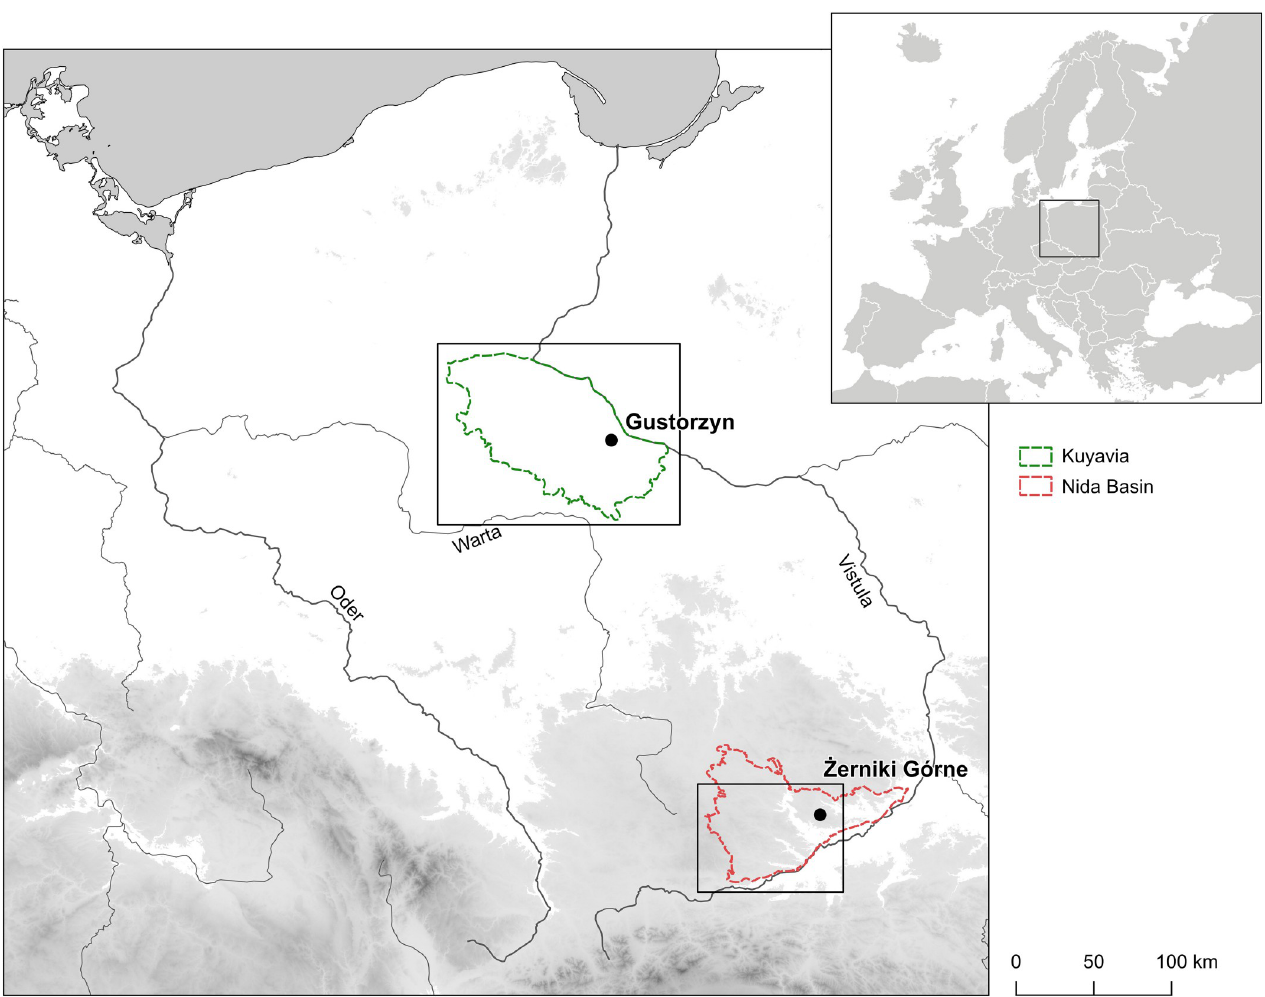
Fig 1. Map of East-Central Europe with location of Kuyavia (green) and Nida Basin (red), and the location of cemeteries in Gustorzyn and Ż erniki Go´rne. Black frames correspond to the ranges of maps shown on Figs 4 and 5. Inset shows location of the study area in Europe. The map was produced with the QGIS 3.26.0 software, using elevation data downloaded from